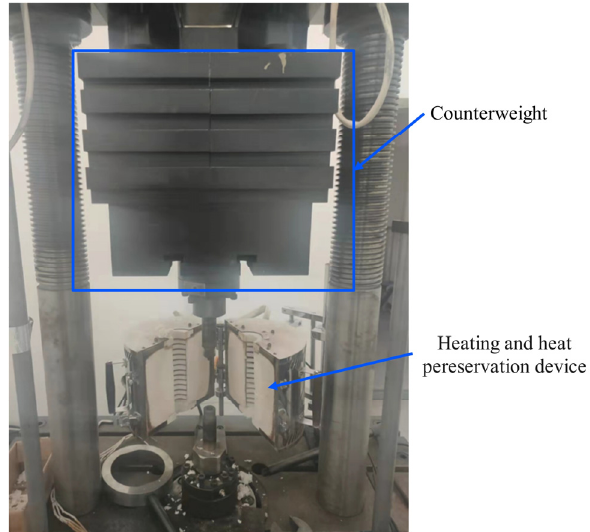
Figure 3. High-temperature and high-frequency fatigue testing machine for residual stress relief experiments.